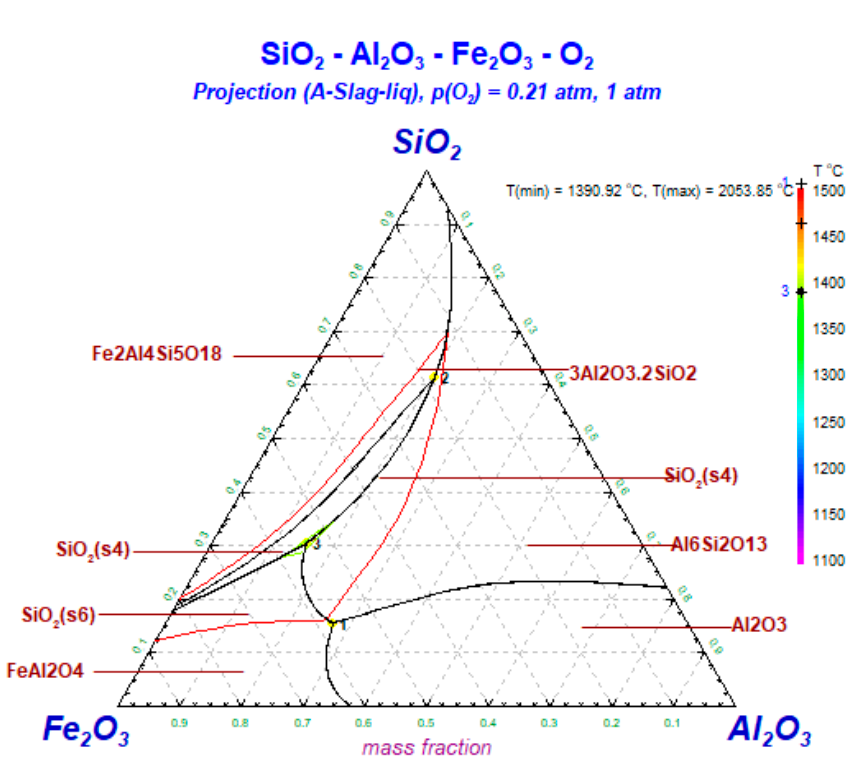
Figure 14. Phase diagram of Al 2 O 3 -SiO 2 -Fe 2 O 3 during oxidation.